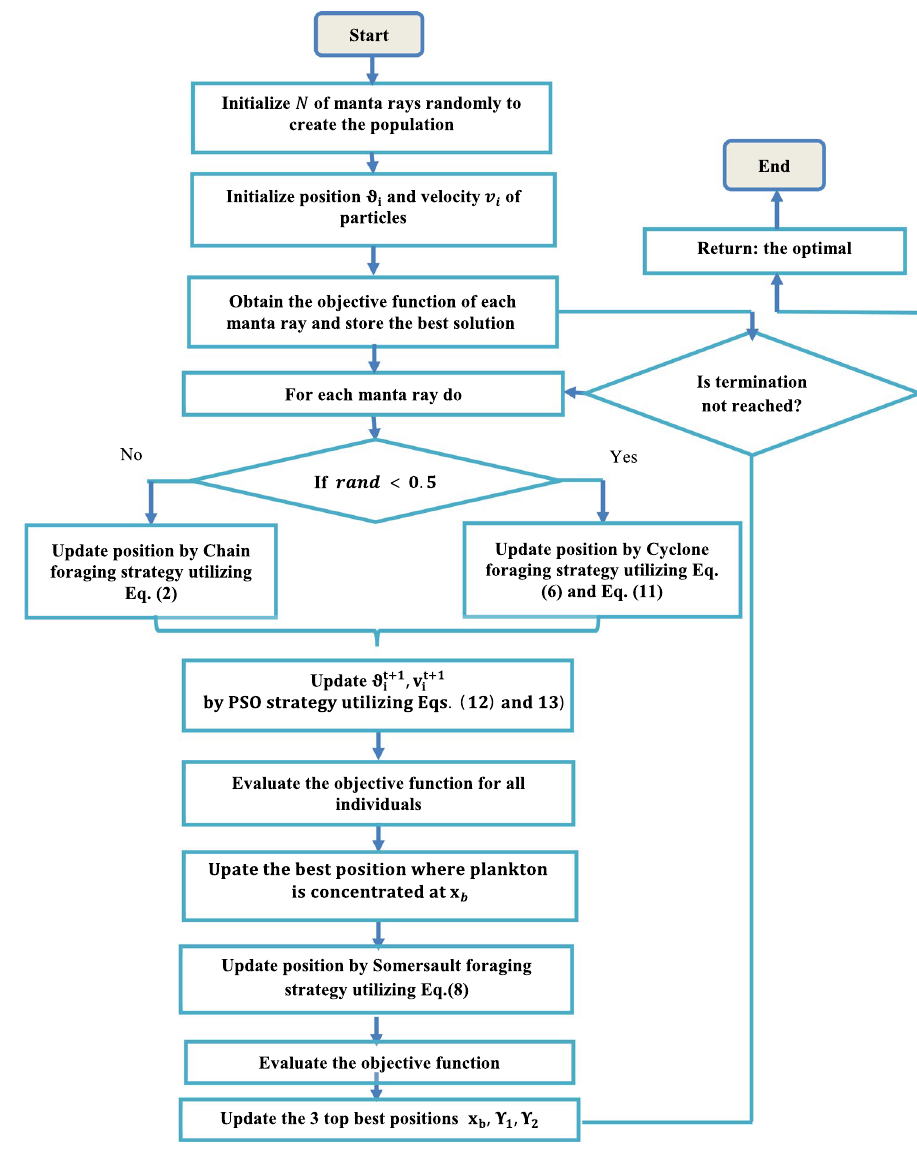
Fig. 2 The flowchart of the MRFO-PSO